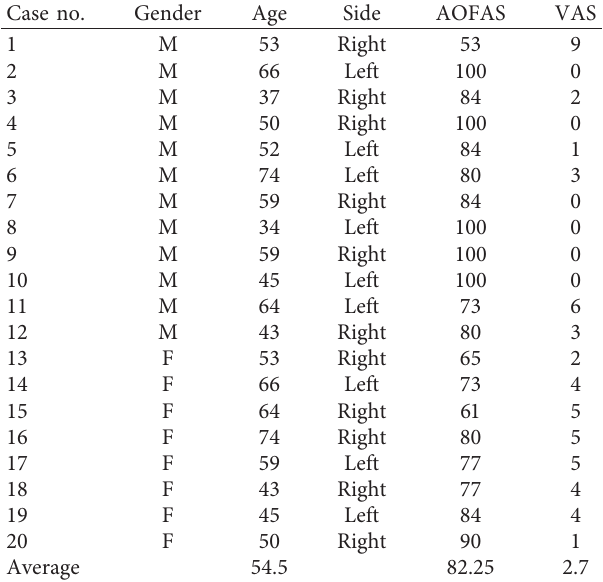
Table 1: AOFAS and VAS score. Case